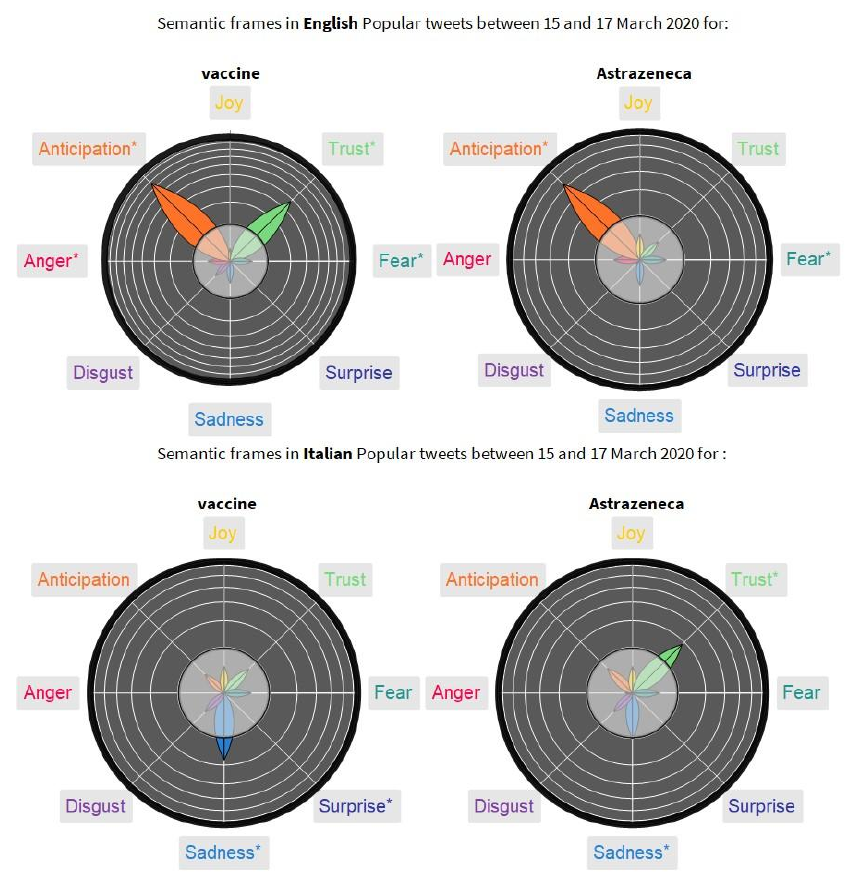
Figure 6. Emotional flowers for “vaccine” and “astrazeneca” in popular tweets gathered after the suspension of the AstraZeneca vaccine in several EU countries in mid-March 2021. These results should be compared with the emotional profiles reported in Figure 2 and relative to the months before the suspension. Asterisks highlight emotions z > 1.96.